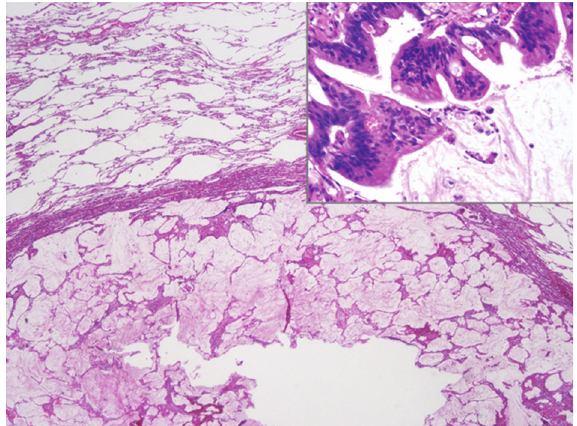
Figure 2: Histological findings of the lung nodule: atypical cells with histological characteristics similar to appendiceal tumor invaded pulmonary